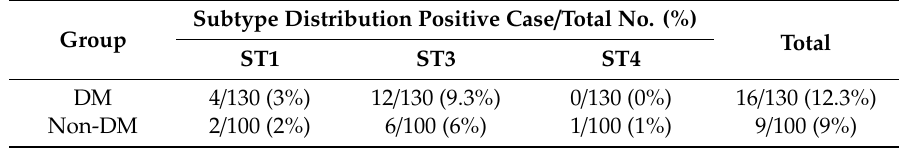
Table 5. Subtype distribution in the diabetes mellitus (DM) and non-DM